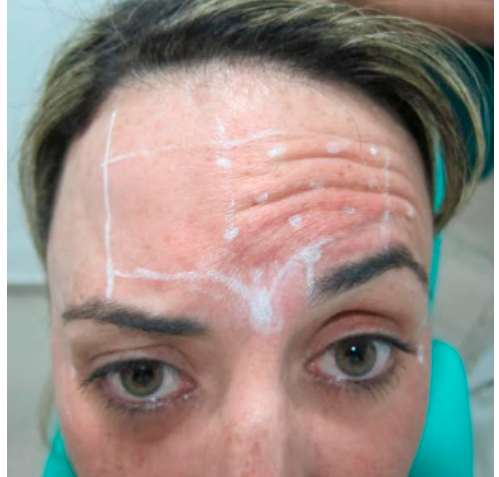
Figure 3. The patient was adequately marked in their limits and safety zones. Individual markings were performed in the active region of the frontal muscle, with 1 to 1.5 cm of distance, and 2U of the toxin was injected (Botulift 100U). A central point was made in the procerus muscle, and 6U was injected. Then, 4U was injected in the corrugator muscle of the eyebrow on the left